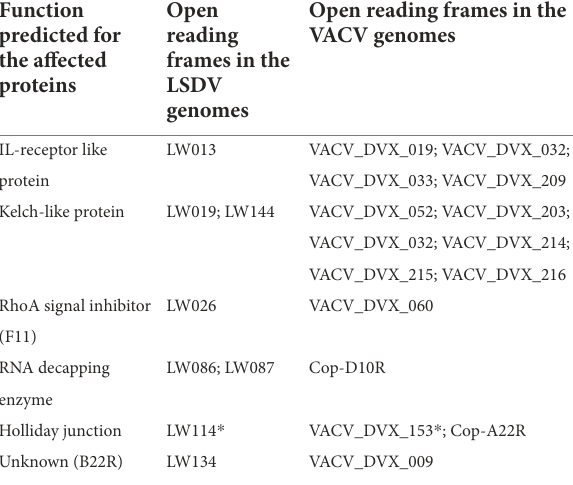
TABLE 1 Predicted proteins displaying differences due to frameshift mutations in both LSDV and VACV (Kara et al., 2003; Qin et al., 2011, 2013; Senkevich et al., 2020; van Schalkwyk et al., 2021). Function predicted